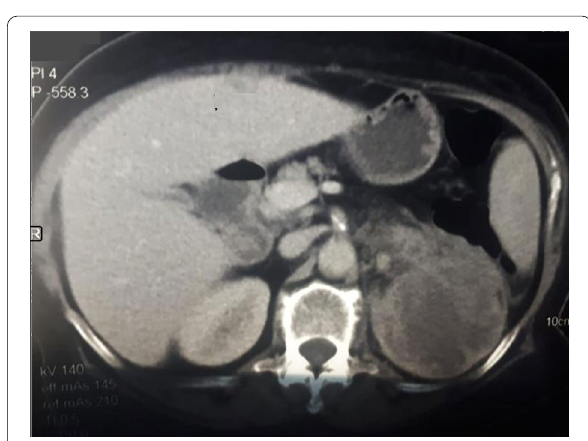
Fig. 2 A preoperative axial CT section showing the